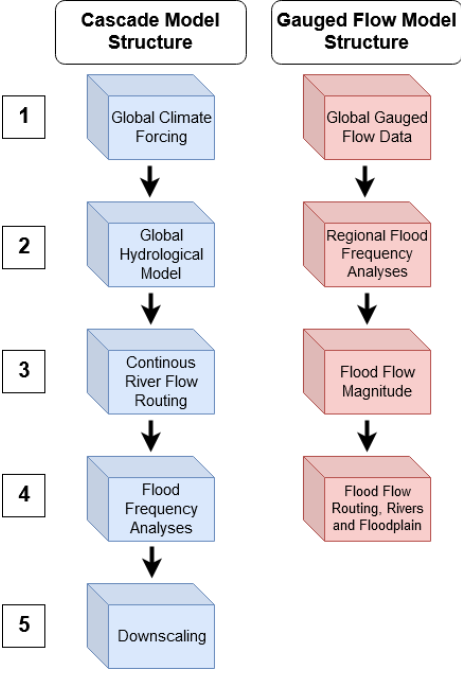
Figure 1. Two types of model structures as introduced by Trigg et al. (2016), with the cascade model structure in blue and the gauged- flow model structure in